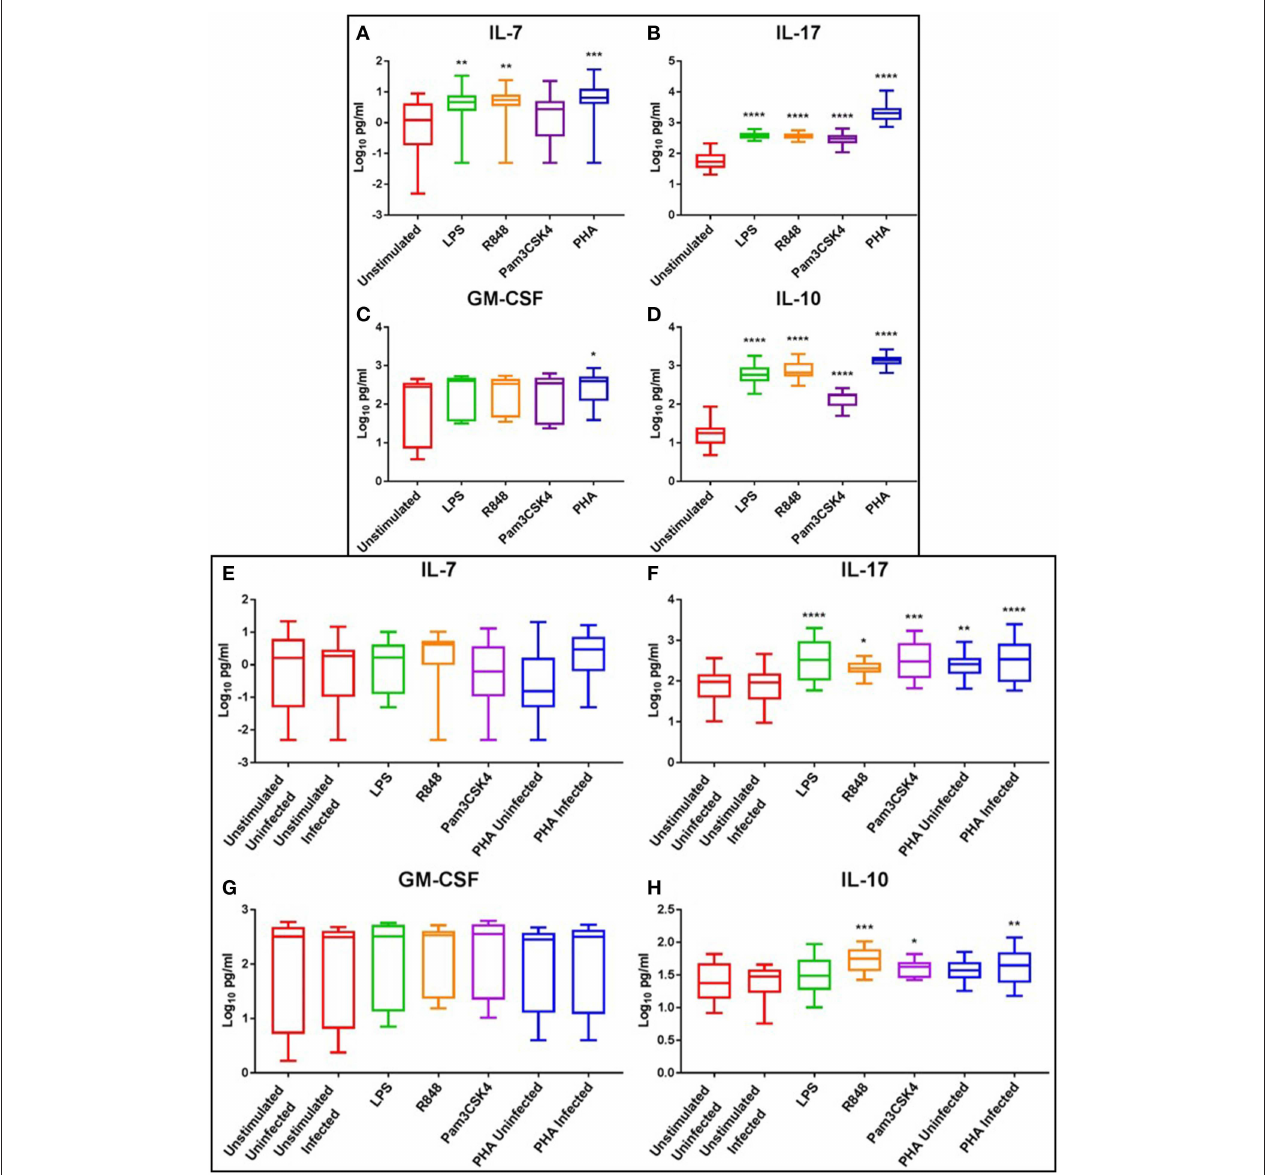
FIGURE 6 | Box and Whisker plots showing mean ± SD Log10 concentrations of haematopoietic cytokines IL-7 (A,E) and IL-17 (B,F) , the growth factor GM-CSF (C,G) , and the anti-inflammatory cytokine IL-10 (D,H) from unstimulated (red), LPS (green), R848 (orange), Pam3CSK4 (purple), and PHA (blue) conditions on day 3 prior to HIV infection (top box: A–D ) and day 5 post HIV infection (bottom box: E–H ). TLR agonists were used at a final concentration of 2 µ g/ml. PHA was used at a final concentration of 10 µ g/ml. All TLR stimulation conditions were infected. An ordinary one-way ANOVA with a Dunnett’s multiple comparisons test was